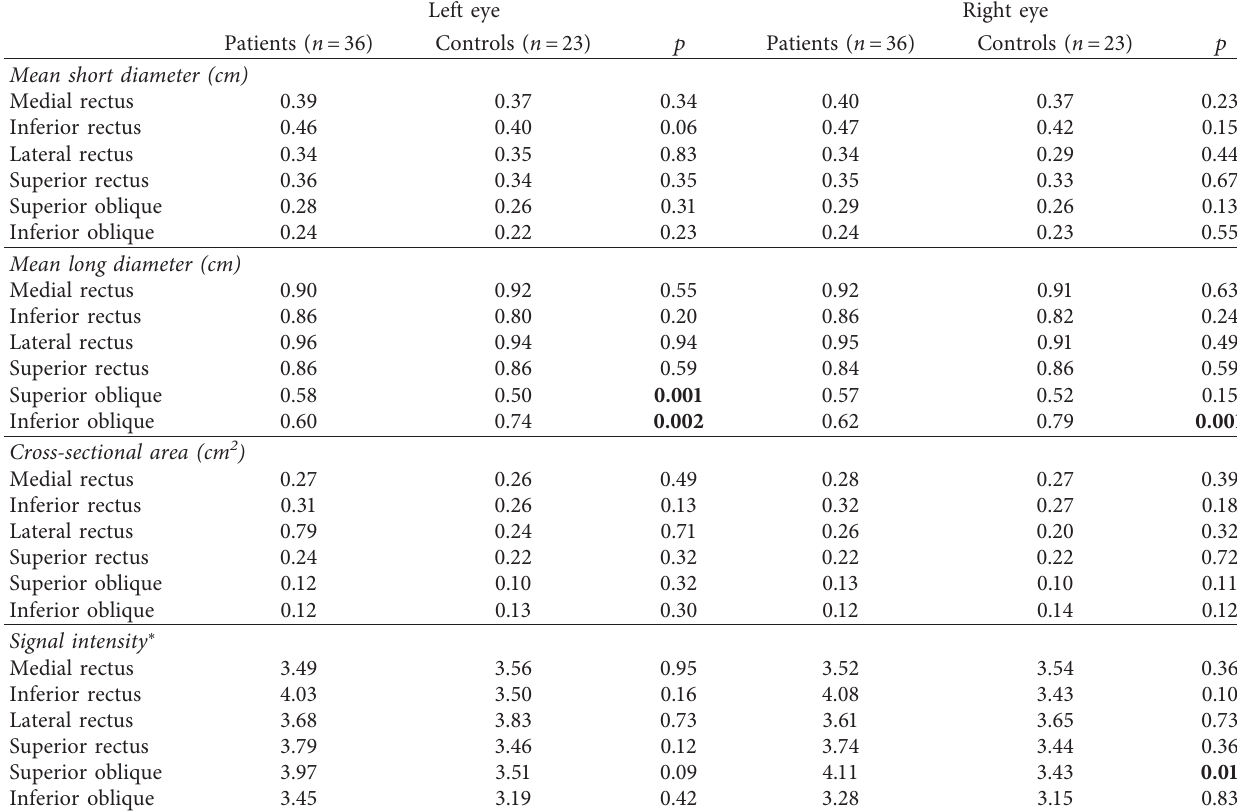
Table 2: Comparisons of GO patients and controls for MRI examination findings of EOM. Left